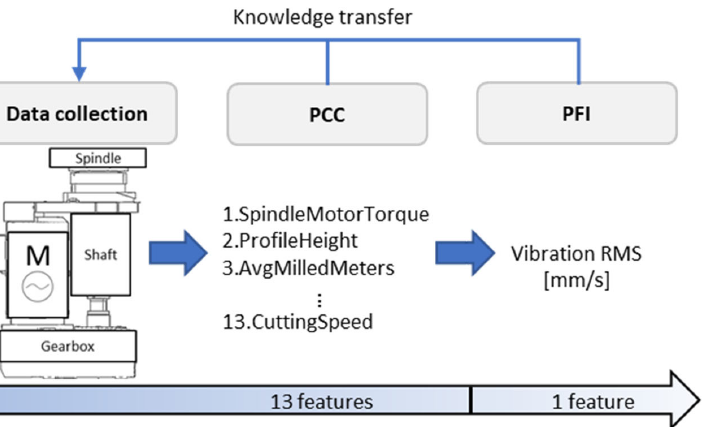
Figure 6. Feature reduction pipeline with PCC and PFI methods resulting in added wear behaviour Figure knowledge.